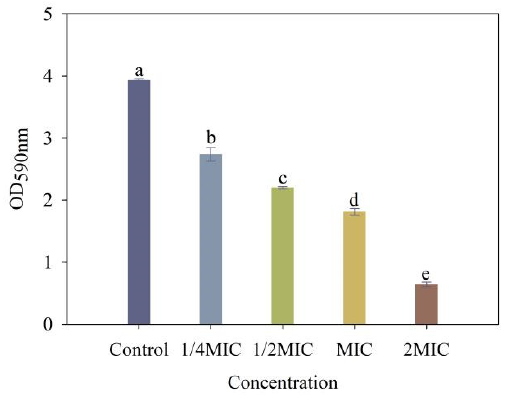
Figure 8. Effect of different concentrations of 4-allylbenzene-1,2-diol on biofilm formation of Xoo. Note: Different lowercase letters show the significant difference at p < 0.05 level using Duncan’s new multiple range test, respectively.